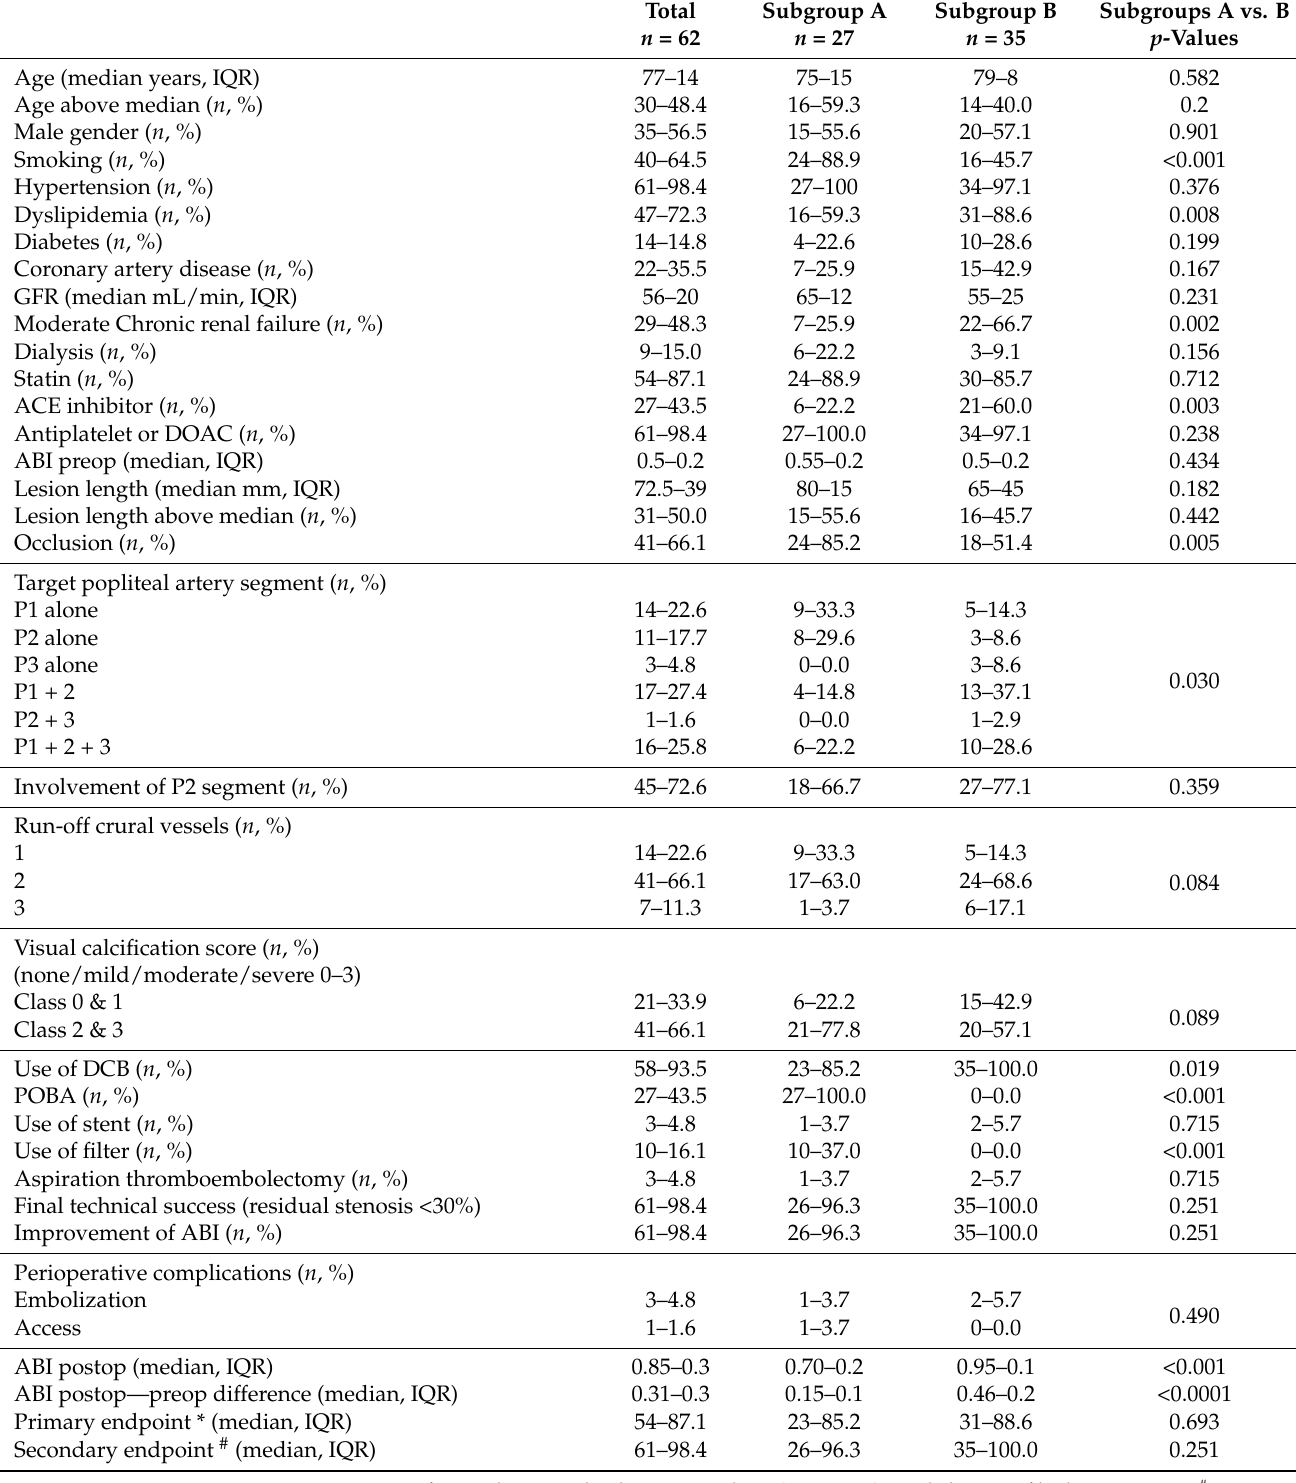
Table 1. Demographic and procedural data in patients with isolated popliteal artery